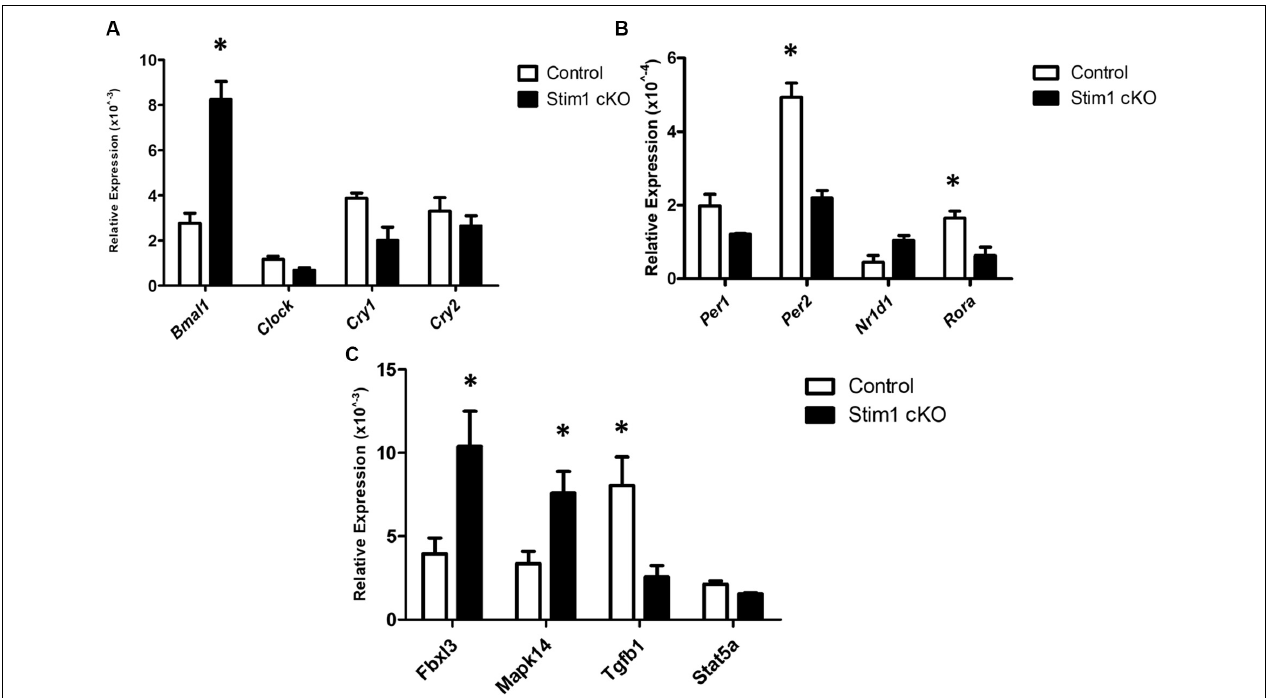
FIGURE 2 | The validation for selected candidate genes by qRT-PCR (A–C) . Data showed the relative mRNA fold changes of candidate genes in Stim1 cKO groups versus the control groups ( n = 5 per genotype). All experiments were performed in triplicates ( ∗ P <